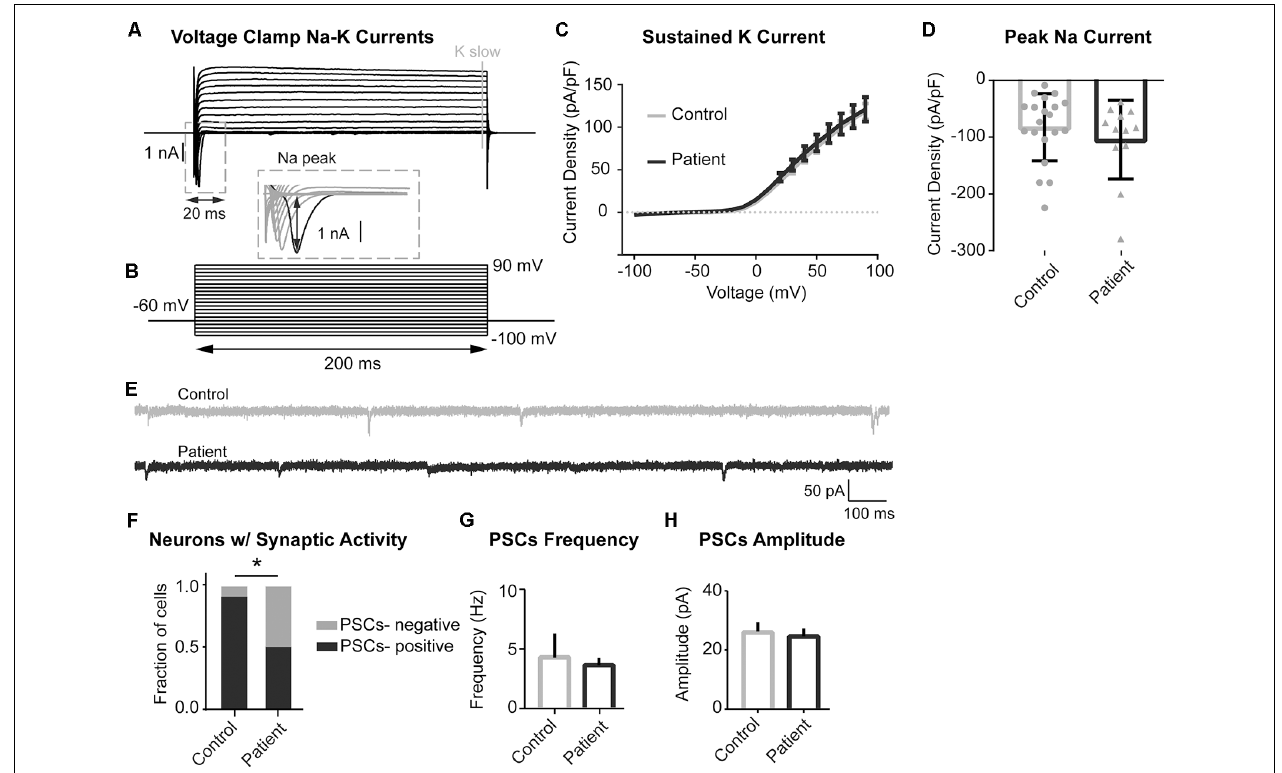
FIGURE 6 | Sodium and Potassium conductances and synaptic activity in control and mutant neurons. ( A,B) Example recording (A) and voltage-clamp protocol (B) used to evoke voltage-gated sodium and potassium conductances. (A) Series of the voltage clamp traces recorded from the control neuron. Inward fast currents, expanded in the inset window, demonstrate the presence of the sodium conductances. Peak Na current is labeled with black arrowheads. Outward slow conductances measured at the end of the voltage step (labeled with gray solid line) represent slow potassium currents. (B) Series of 200 ms voltage steps from − 100 to +90 mV at 10 mV intervals, holding potential between steps is − 60 mV. (C) Summary data of slow potassium conductances represented as Mean ± SEM current density (Y-axis) in function of voltage (X-axis); sample sizes: Control (solid gray line) n = 20, Patient 2 (solid black line) n = 12; multiple t -tests for each current step, adjusted p values n.s. (D) Summary data of peak sodium currents represented as Mean ± SEM current density; sample sizes: Control (gray bar) n = 20, Patient 2 (black bar) n = 12; Unpaired Student’s t -test, F = 0.7385, p = 0.3526 (n.s). (E) Example traces of recordings of spontaneous postsynaptic currents (PSCs) acquired in voltage-clamp mode with the membrane clamped at − 60 mV. Control—gray, Patient 2–black. (F) Summary data of the proportion of neurons demonstrating spontaneous synaptic activity, data represented as a fraction of recorded cells with (black) and without (gray) detected PSCs; sample sizes: Control n = 19, Patient 2 n = 12; Fisher’s exact test, df = 2, * p = 0.0316. (G) Summary data of PSCs Frequency (only PSCs-positive cells), data represented as Mean ± SEM; sample sizes: Control (gray bar) n = 17, Patient 2 (black bar) n = 6; Mann–Whitney test, exact p = 0.5069 (n.s.). (H) Summary data of PSCs Amplitude (only PSCs-positive cells), data represented as Mean ± SEM; sample sizes: Control (gray bar) n = 17, Patient 2 (black bar) n = 6; Mann–Whitney test, p = 0.2863